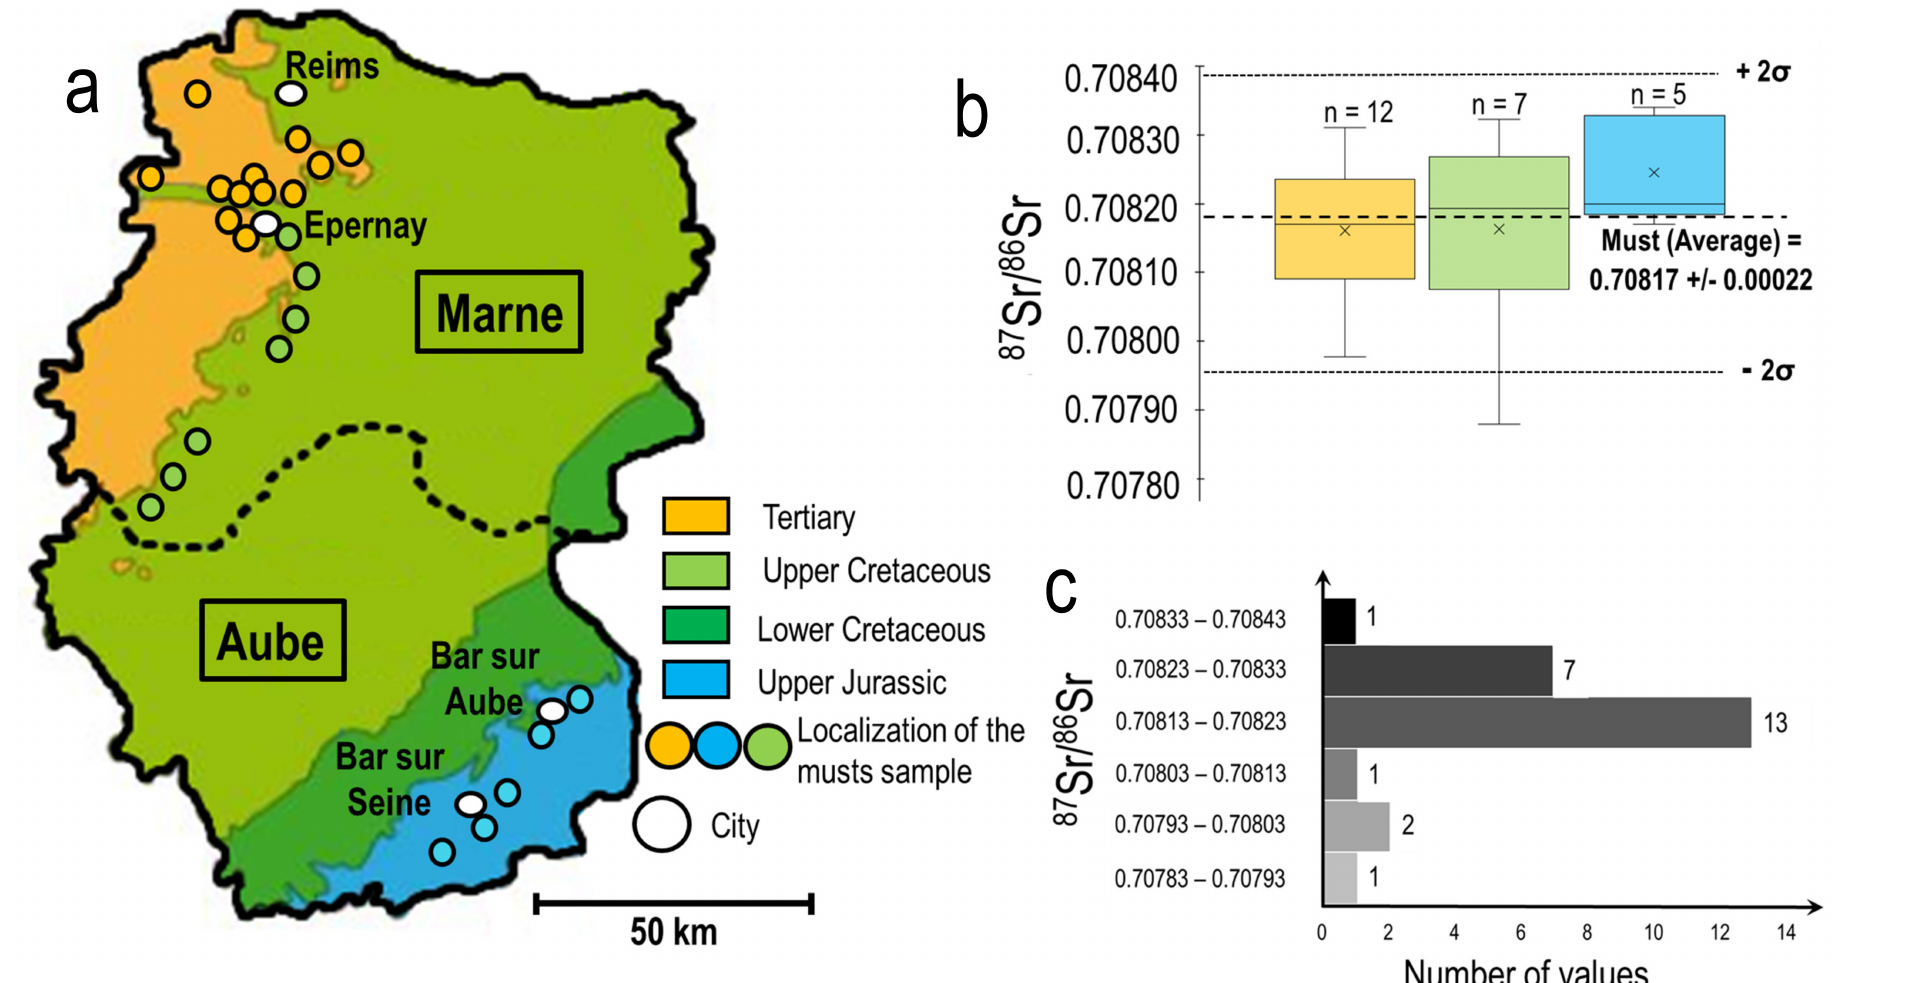
Figure 3. ( a ) Projection of the musts samples as a function of the type of bedrock, ( b ) associated Sr isotopic ratios measured in musts, ( c ) the distribution of the 87 Sr/ 86 Sr values of the